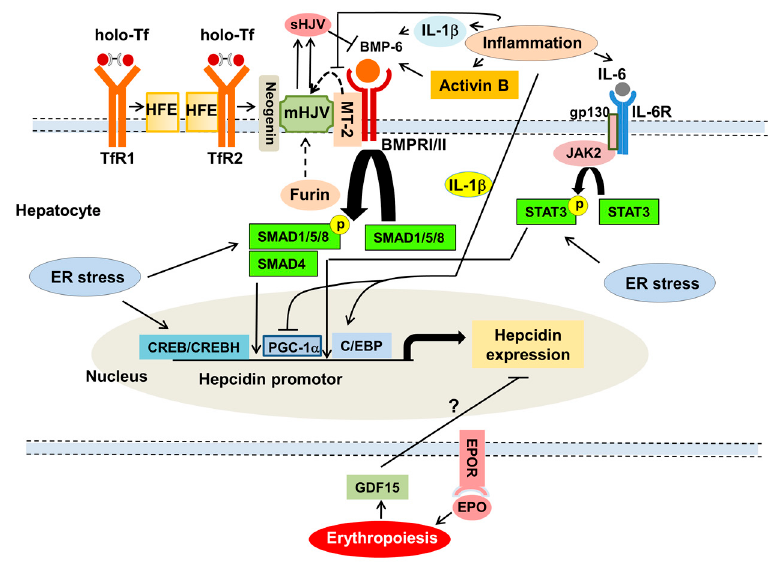
Figure 2. Regulation of hepcidin by iron status and inflammation. Under high iron conditions, increased holo-Tf induces bone morphogenetic protein (BMP)-6 in non-parenchymal cells in the liver, disrupts hereditary hemochromatosis protein (HFE)-transferrin receptor (TfR)1 interaction to promote HFE-TfR2 interaction and its association with membrane-anchored hemojuvelin (mHJV), forming a complex of HFE/TfR2/BMP-6/BMPR/HJV/neogenin, which is dispensable for hepcidin transcription via BMP/small mothers against decapentaplegic (SMAD) signaling. In iron overload, furin, which cleaves mHJV, is downregulated, thereby increasing hepcidin. Low iron conditions increase matriptase (MT)-2 and furin, which cleaves mHJV, reduces BMP-6 production and facilitates the HFE-TfR1 interaction, leading to inhibition of BMP/SMAD-dependent hepcidin transcription. Pro-inflammatory cytokines such as interleukin (IL)-1 β and IL-6 stimulate hepcidin expression via the Janus kinase (JAK)/signal transducers and activators of transcription (STAT)3 signaling. Inflammation induces other cytokine, activin B, which stimulates BMP/SMAD signaling, synergically with IL-6 and STAT3 signaling, leading to hepcidin expression. Endoplasmic reticulum (ER) stress associated with inflammation increases hepcidin via SMAD1/5/8 and cyclic-AMP-responsive-element-binding protein (CREB)H that binds and activates hepcidin promoter activity. Inflammation increases hepcidin by inhibiting MT-2 via decreased STAT5 and peroxisome proliferator-activated receptor γ coactivator (PGC)-1 α which antagonizes lipopolysaccharide-induced hepcidin transcription via the interaction with hepatocyte nuclear factor 4 α . Inflammation-induced IL-1 β enhances hepcidin transcription by inducing CCAT enhancer-binding protein (C/EBP) δ . Hepcidin translation is mediated indirectly through erythropoietin (EPO)/EPOR-induced erythropoiesis and possibly growth differentiation factor (GDF)15. gp130: glycoprotein 130. Dashed line: cleavage, → : activation, ├ : inhibition.